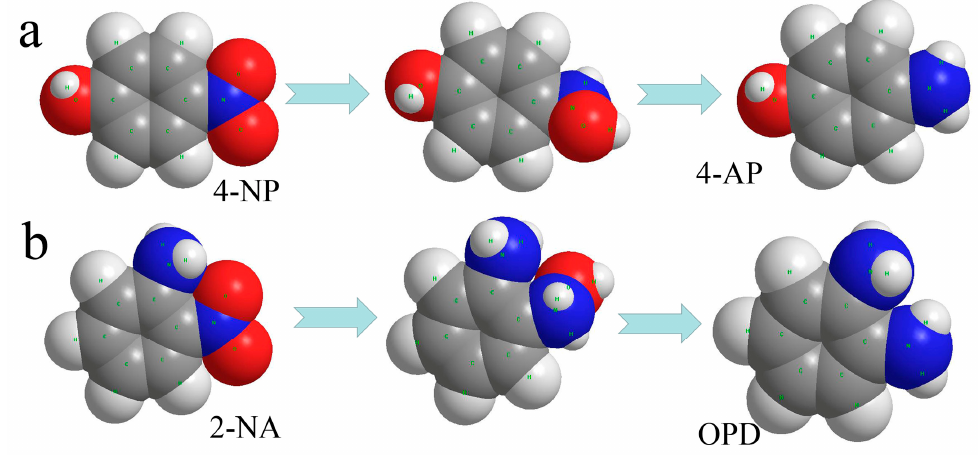
Figure 6. Spatial filling models of 4-NP transforming to 4-AP ( a ) and 2-NA transforming to OPD ( b ).